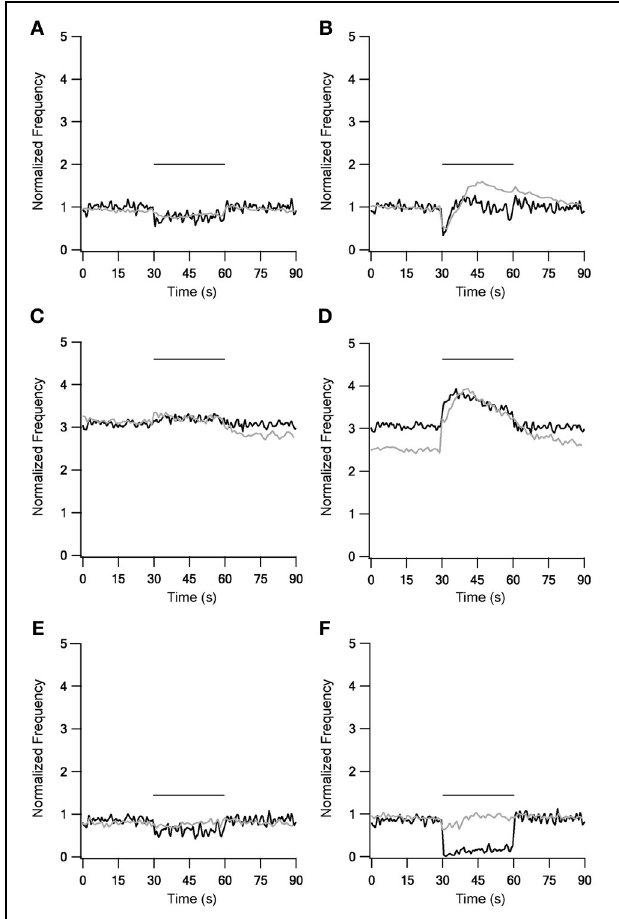
FIGURE 3 | Model and experimental results during LFS and HFS after adding slow kinetics to GP-GP and STN-GP synapses. Left column shows LFS results under control conditions (A) , under blockade of inhibition (C) and blockade of excitation (E) . Right column shows HFS results under control conditions (B) , under blockade of inhibition (D) and blockade of excitation (F) . Plotted as in Figure 1 . Black traces, model results; gray traces, normalized population average recorded from GP neurons in vitro (Bugaysen et al., 2011). Horizontal bars indicate the stimulation period. In these experiments inhibition was blocked with 50 μ M bicuculline and excitation with 15 μ M CNQX and 50 μ M